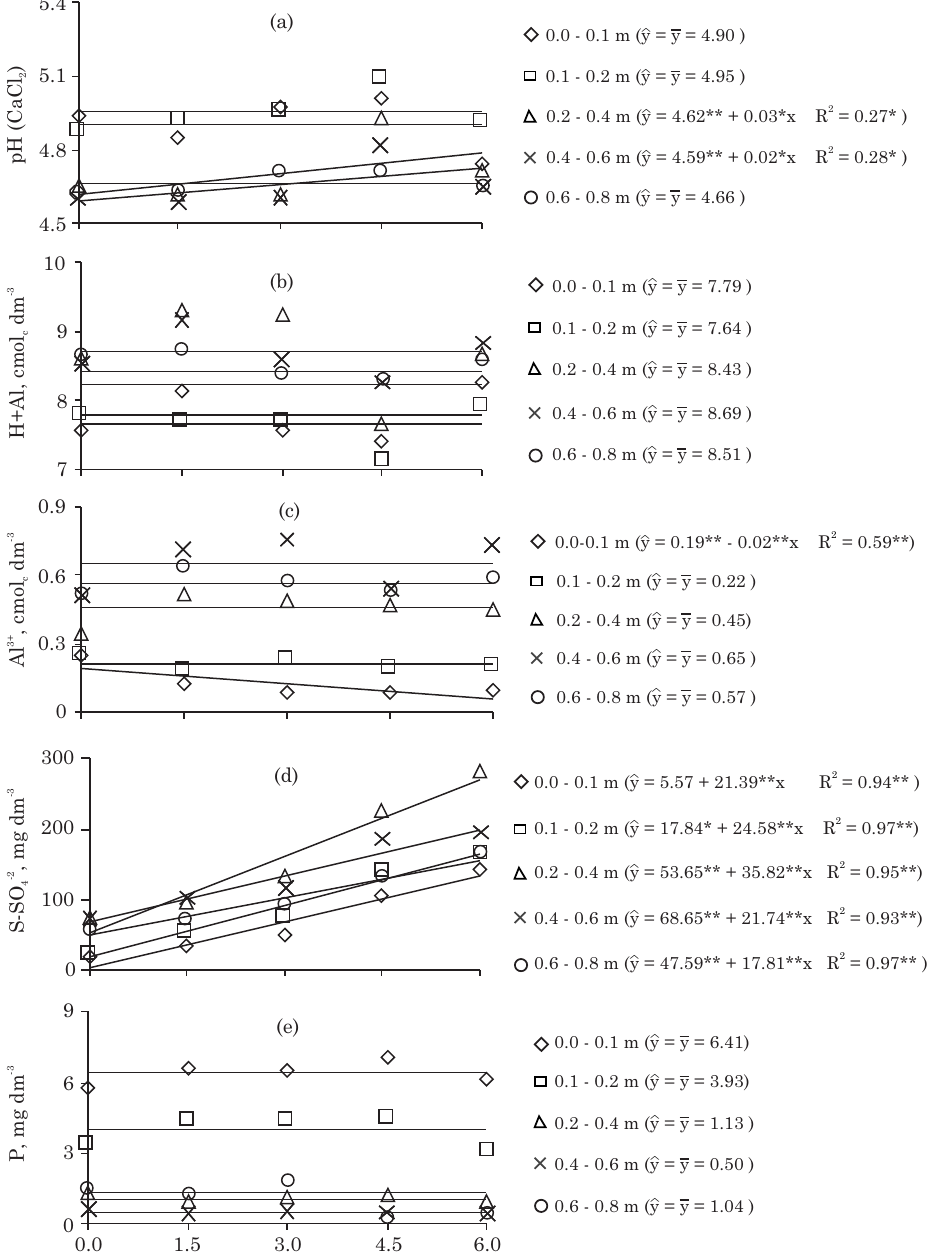
Figure 2. Active (pH) and potential (H+Al) soil acidity, exchangeable aluminum (Al 3+ ), sulfur (S), and phosphorus (P) levels in soil layers, six months after surface application of gypsum under a no-till system. * p<0.05 and **